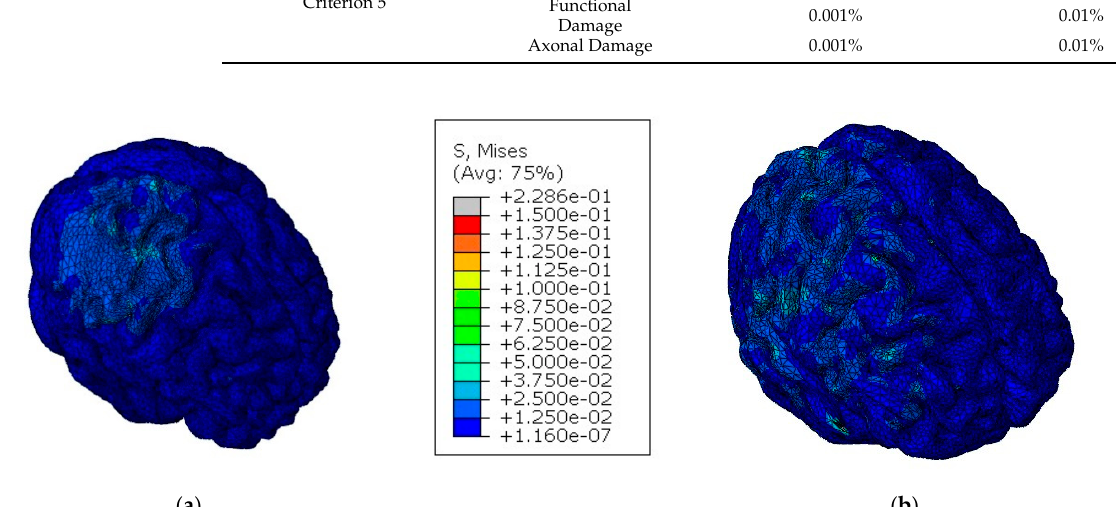
Figure 8. Von Mises stress on the brain for both models [MPa]: ( a ) model with the implant; ( b ) model with an integral skull.